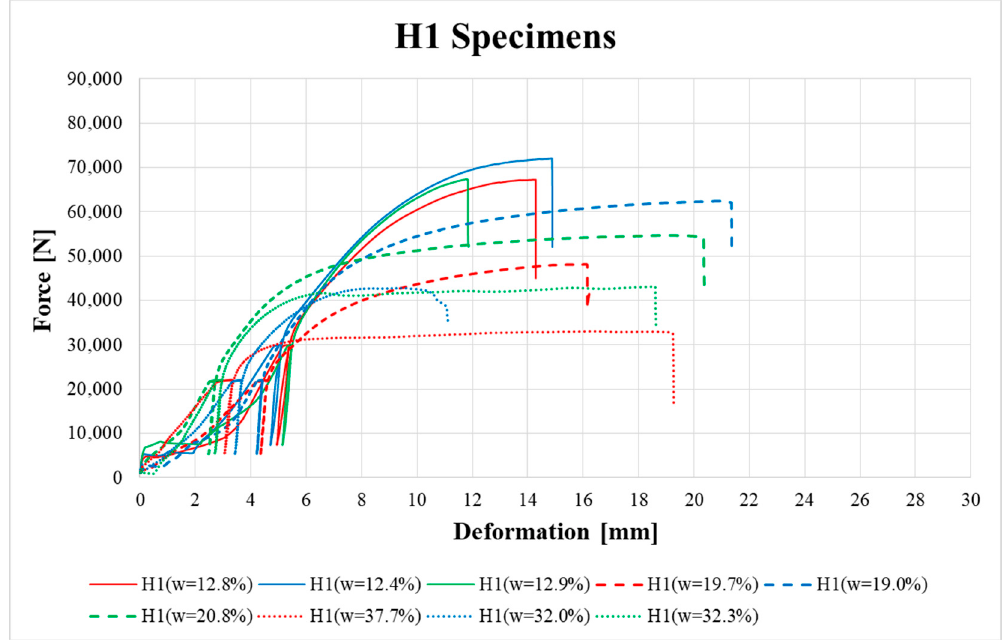
Figure 9. Load–deformation curves of H1 specimens.